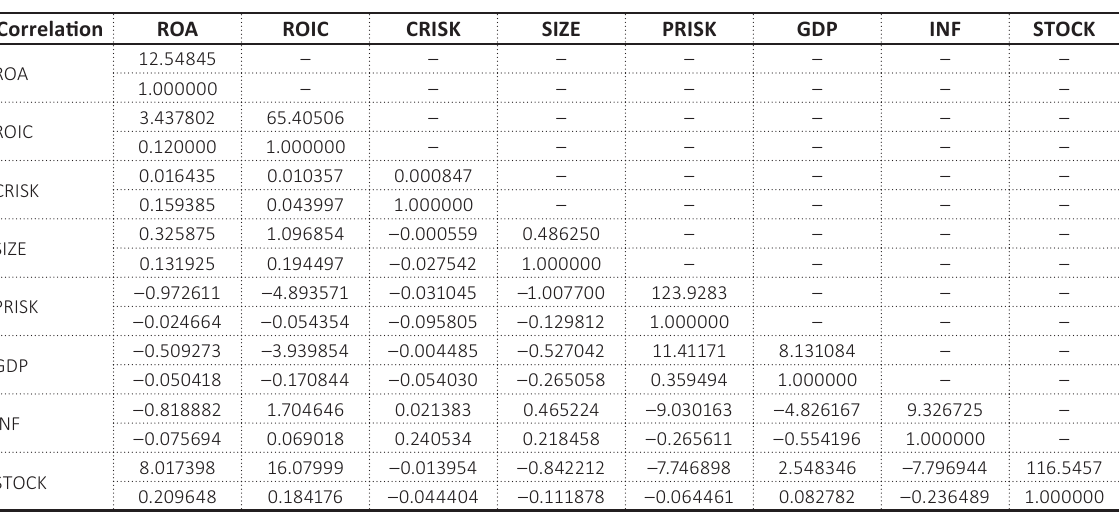
Table 2. Pearson correlation